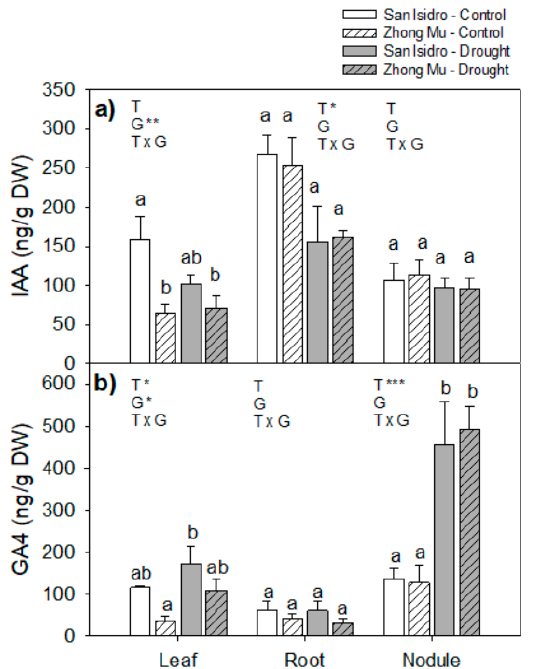
Figure 6. ( a ) Indole-3-acetic acid acid (IAA) and ( b ) gibberellin 4 (GA 4 ) content in leaves, roots and nodules under control and drought condition in two cultivars of Medicago sativa : San Isidro and Zhong Mu. Each value represents the mean ± SE ( n = 6). The different letters indicate significant differences ( p < 0.05). Asterisks indicate significant differences: * p < 0.05, ** p <